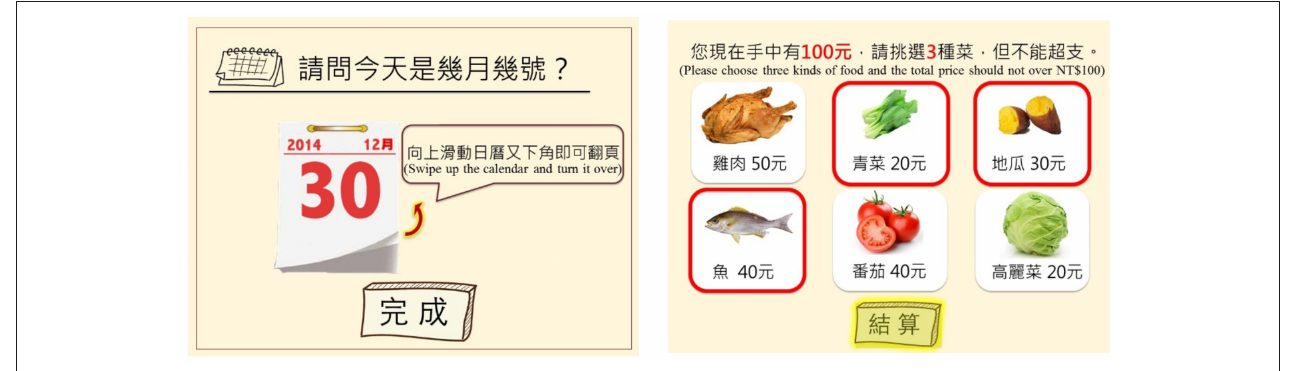
FIGURE 6 | Refined interfaces of My calendar and Shopping in the